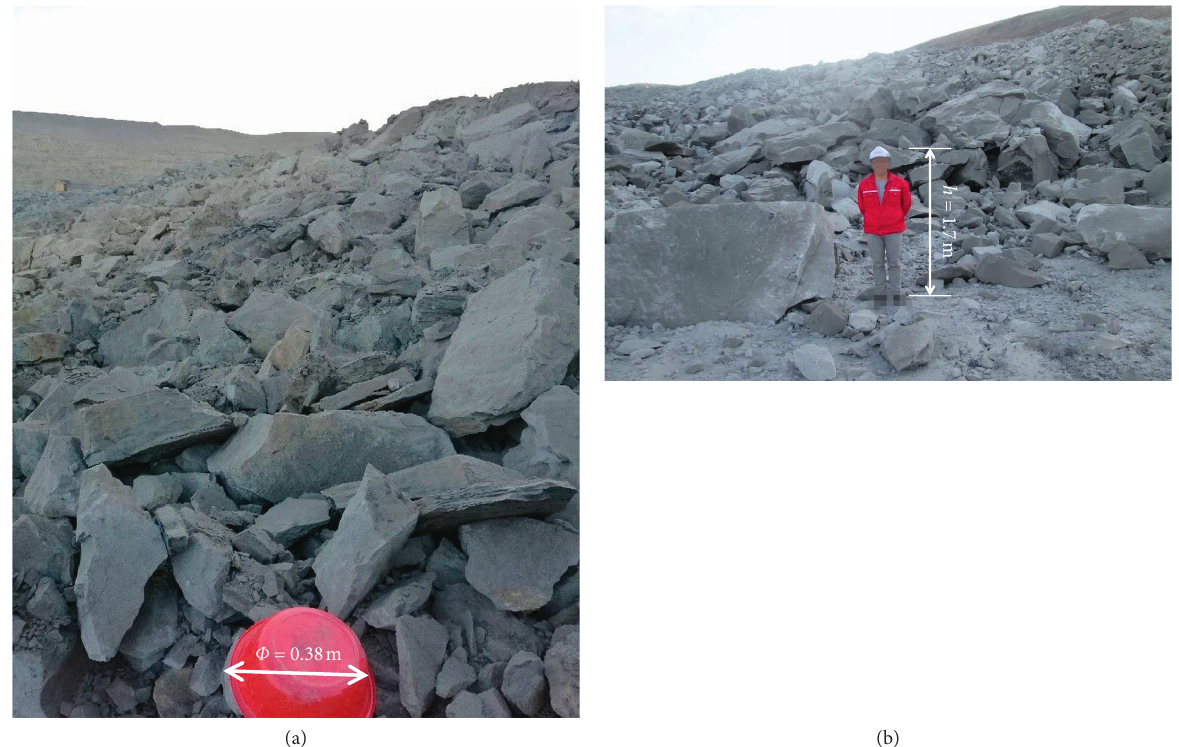
Figure 16: Comparative analysis of rock mass crushing. (a) Crushing result of rock mass in the test group. (b) Crushing result of rock mass in the control group.